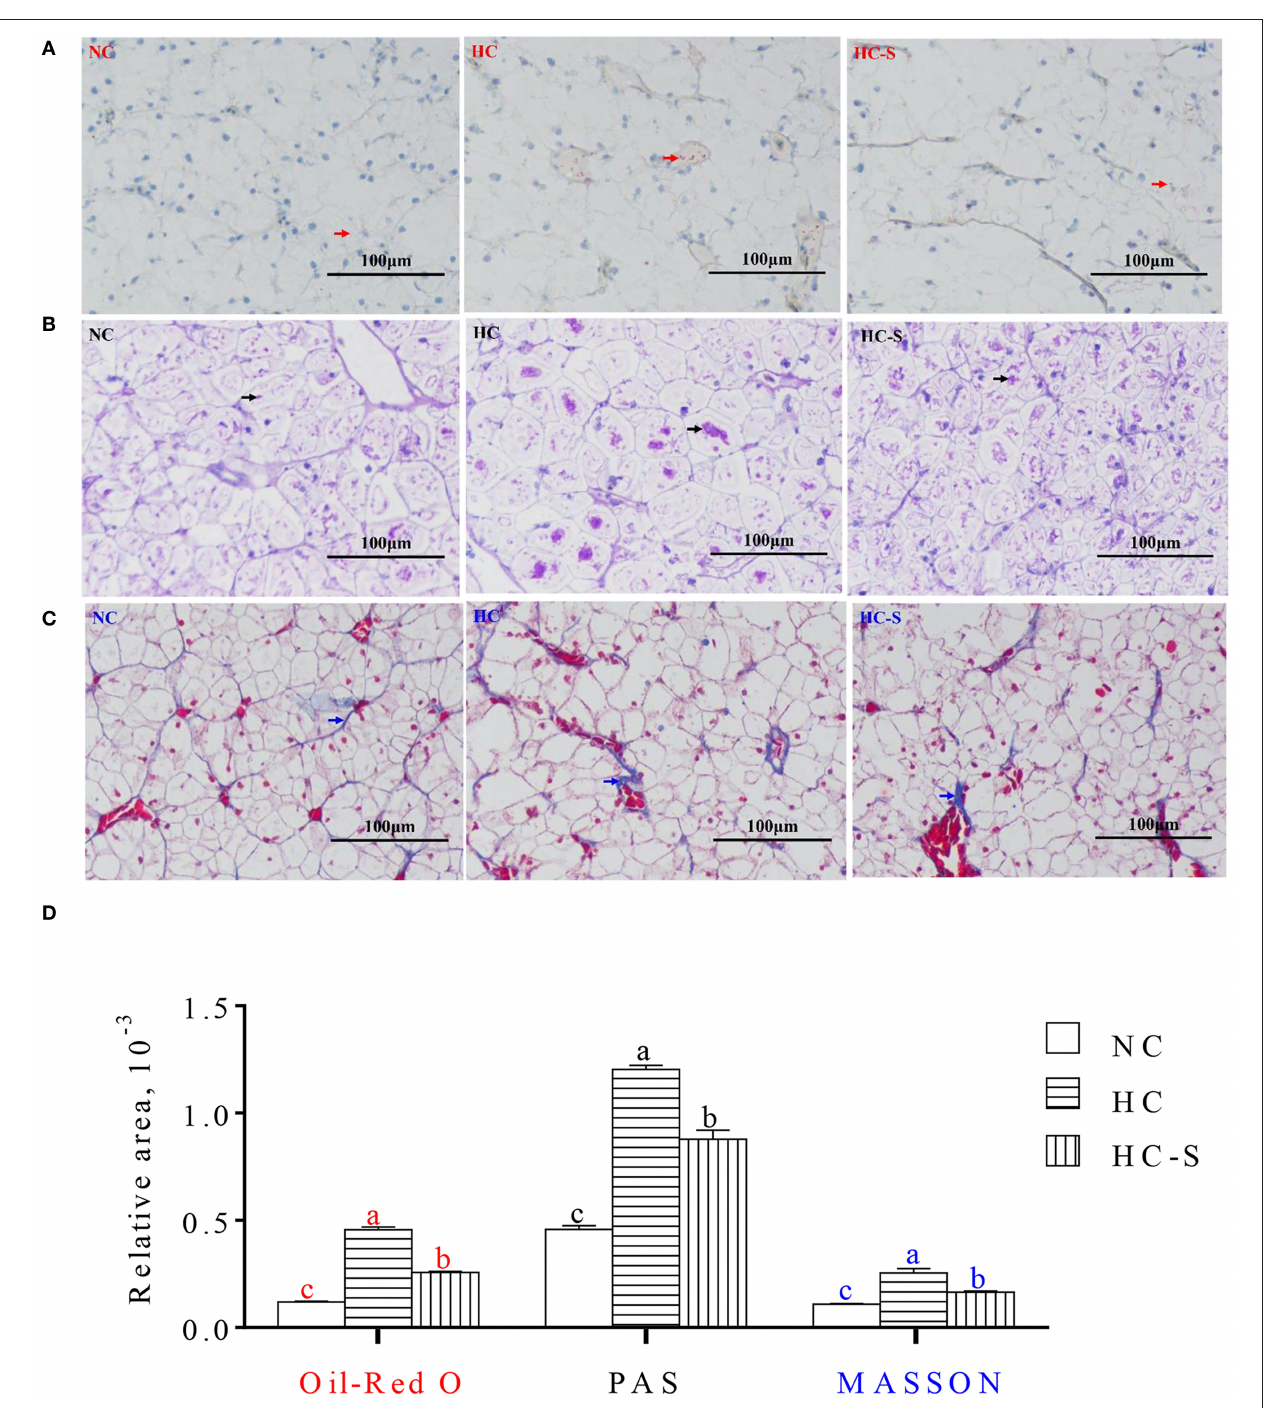
FIGURE 1 | Influence of dietary Saccharina japonica (SJ) on hepatic histological structure of paraffin slice with Oil Red O (making nucleus blue and lipid red) staining (A) , PAS (making glycogen carmine) staining (B) and Masson (making collagen fiber blue) staining (C) , and the relative areas of lipid droplet with red arrows in Oil-Red O staining, glycogen with black arrows in PAS staining, and collagen fiber with blue arrows in MASSON staining of swamp eel fed high-carbohydrate (HC) diet (D) ( × 200). Values are presented as means ± SEM, n = 16 fish/diet. Means with different letters were significantly different ( p < 0.05). ACA, CDCA, and GLCA were inversely correlated with HSI Moreover, pairwise Spearman’s correlation analysis showed that and serum GLU ( p < 0.05) ( Figure 4B ). These results indicated serum THCA, TCDCA, TLCA, and NorDCA were positively that serum BA of THCA, TCDCA, TLCA, NorDCA, correlated with HSI and serum GLU, whereas serum UCA,